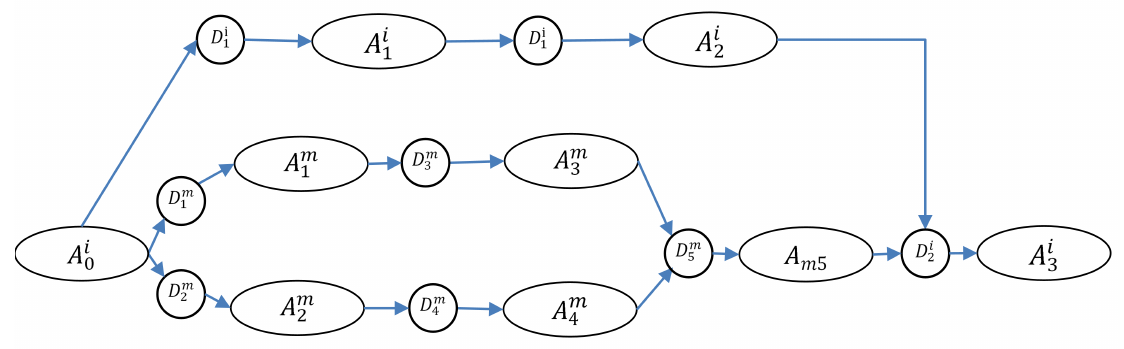
Figure 4. An example of a network with technological operations with delays and technological information operations.